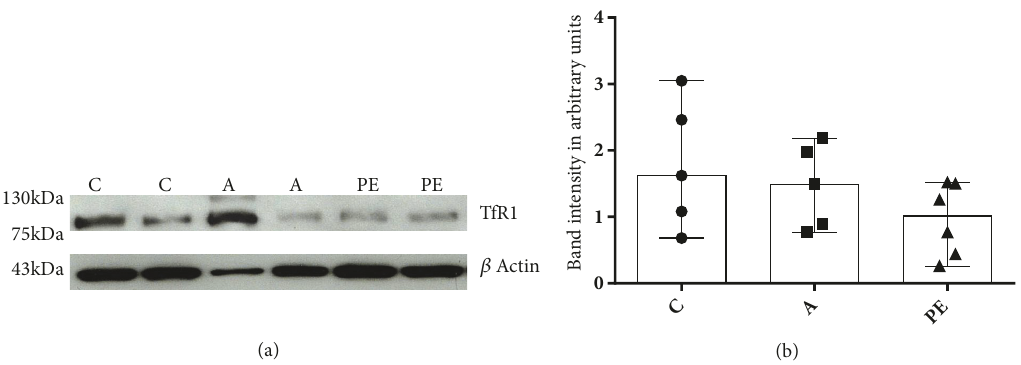
Figure 1: TfR1 expression in placental villi. (a) Representative image of a Western blot (an entire picture is presented in the supplementary figure 4A). (b) Expression of TfR1 in trophoblastic villi in the control group (C) n=5, the group with IDAP (A) n=5 and the group with early- onset severe preeclampsia (PE) n=6. No statistically significant difference in protein expression in the three groups of women was detected. The data are shown expressed as median and range, Kruskal-Wallis statistical analysis.